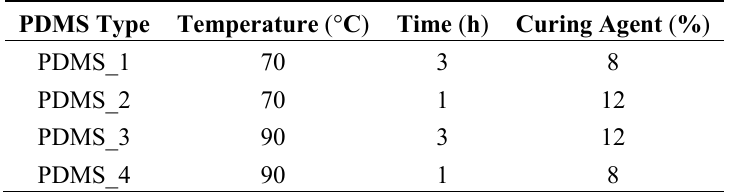
Table 1. Description of the Hadamard’s matrix of experiments with two levels for three parameters tested for polydimethylsiloxane (PDMS) synthesis (heating temperature, heating time and curing agent relative